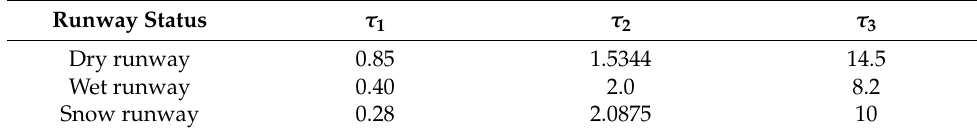
Table 5. Parameters of the runway